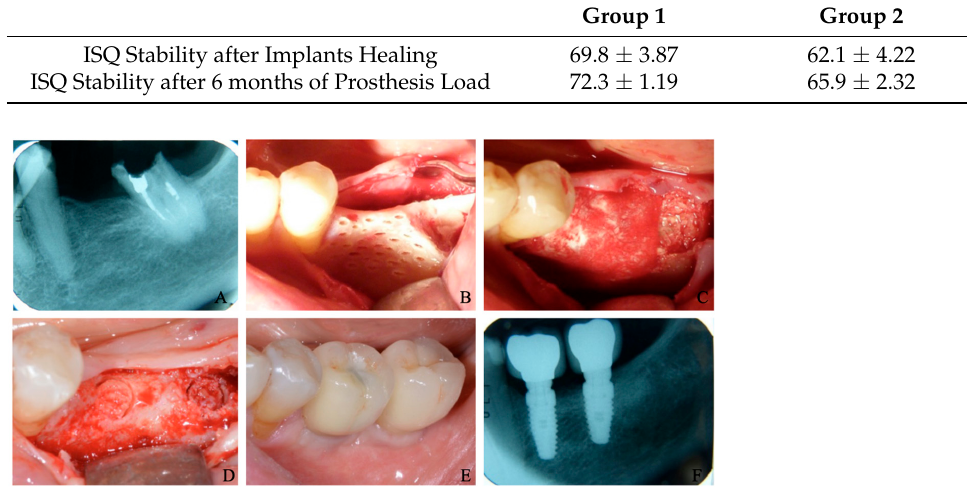
Figure 4. Clinical images of a case of alveolar ridge preservation with the two adjacent procedure types: ( A ) X-ray before the surgery; ( B ) Situation before alveolar ridge augmentation; ( C ) It is possible to note the membrane presence in site 3.6. Dentin graft alone is present in the position of tooth 3.7; ( D ) After 4 months, two biopsies were made on sites 3.6 and 3.7; ( E ) Definitive prosthesis; ( F ) X-ray after 6 months of load.